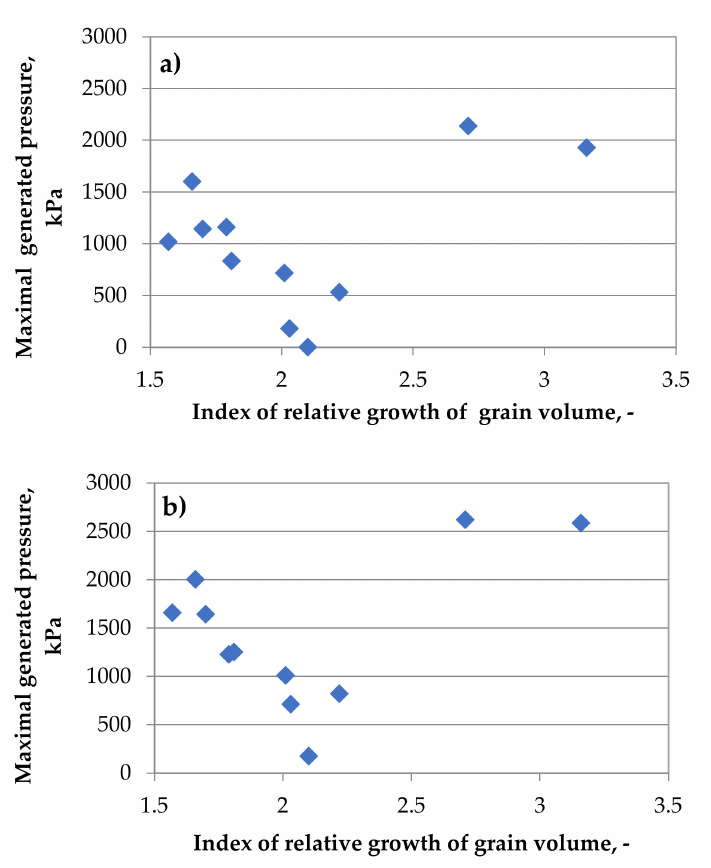
Figure 7. Comparison of maximal coking pressure generated by the plastic layer of the examined coal sample with its index of specific volume increase within the temperature range of coal plasticity: ( a ) bulk density of coal sample: 0.720 g/cm 3 ; ( b ) bulk density of coal sample: 0.800 g/cm 3